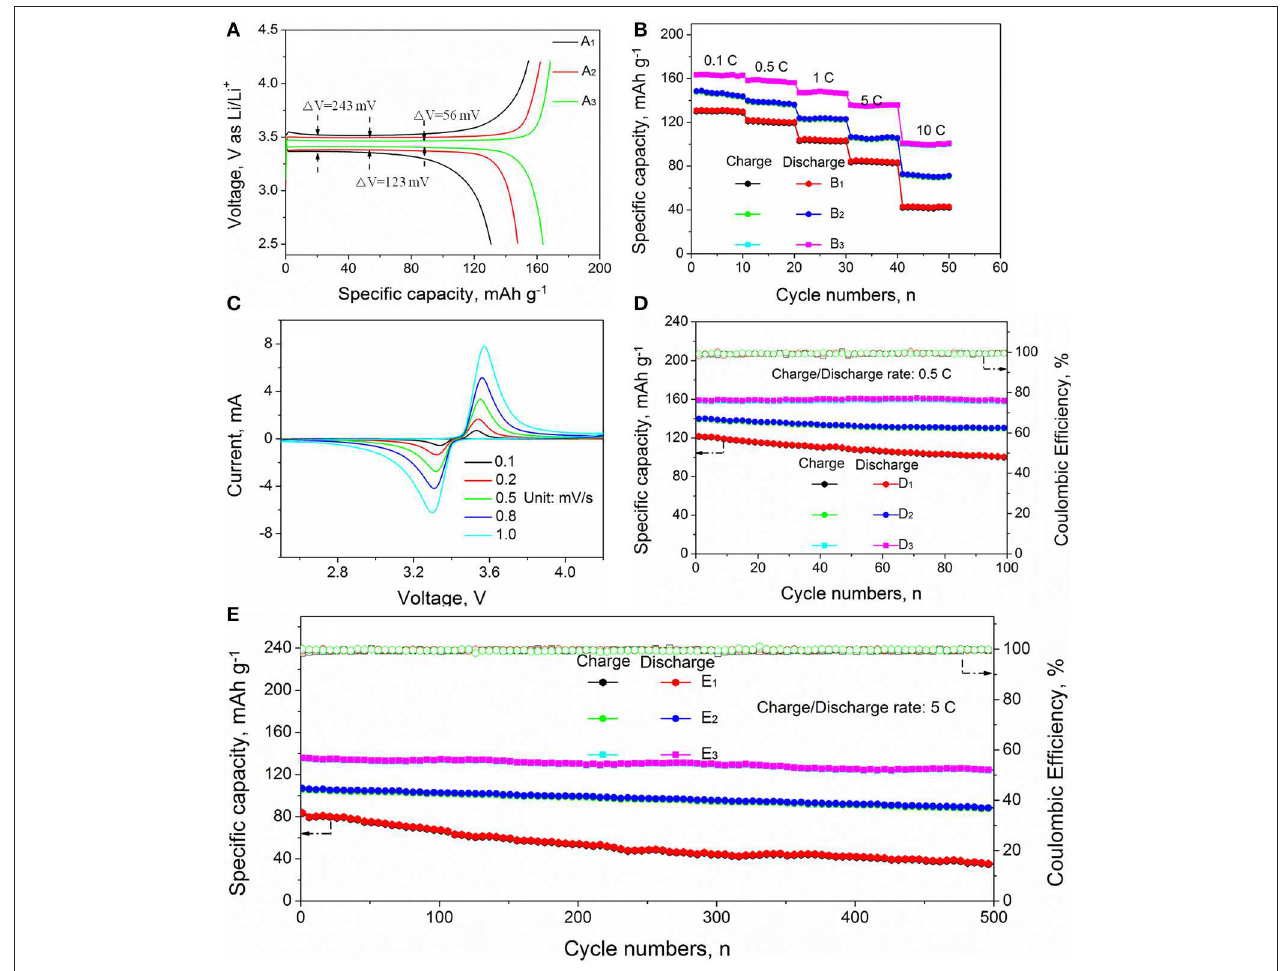
FIGURE 7 | (A) The initial voltage profiles of (A 1 ) pure LFP, (A 2 ) LFP/C, and (A 3 ) LFPF/CF composites; (B) rate performance of (B 1 ) pure LFP, (B 2 ) LFP/C, and (B 3 ) LFPF/CF composites, (C) the CV curves of LFPF/CF composites at different scanning rates and cycling performance at 0.5C rate (D) and 5C rate (E) of (D 1 ,E 1 ) pure LFP, (D 2 ,E 2 ), LFP/C, and (D 3 ,E 3 ) LFPF/CF